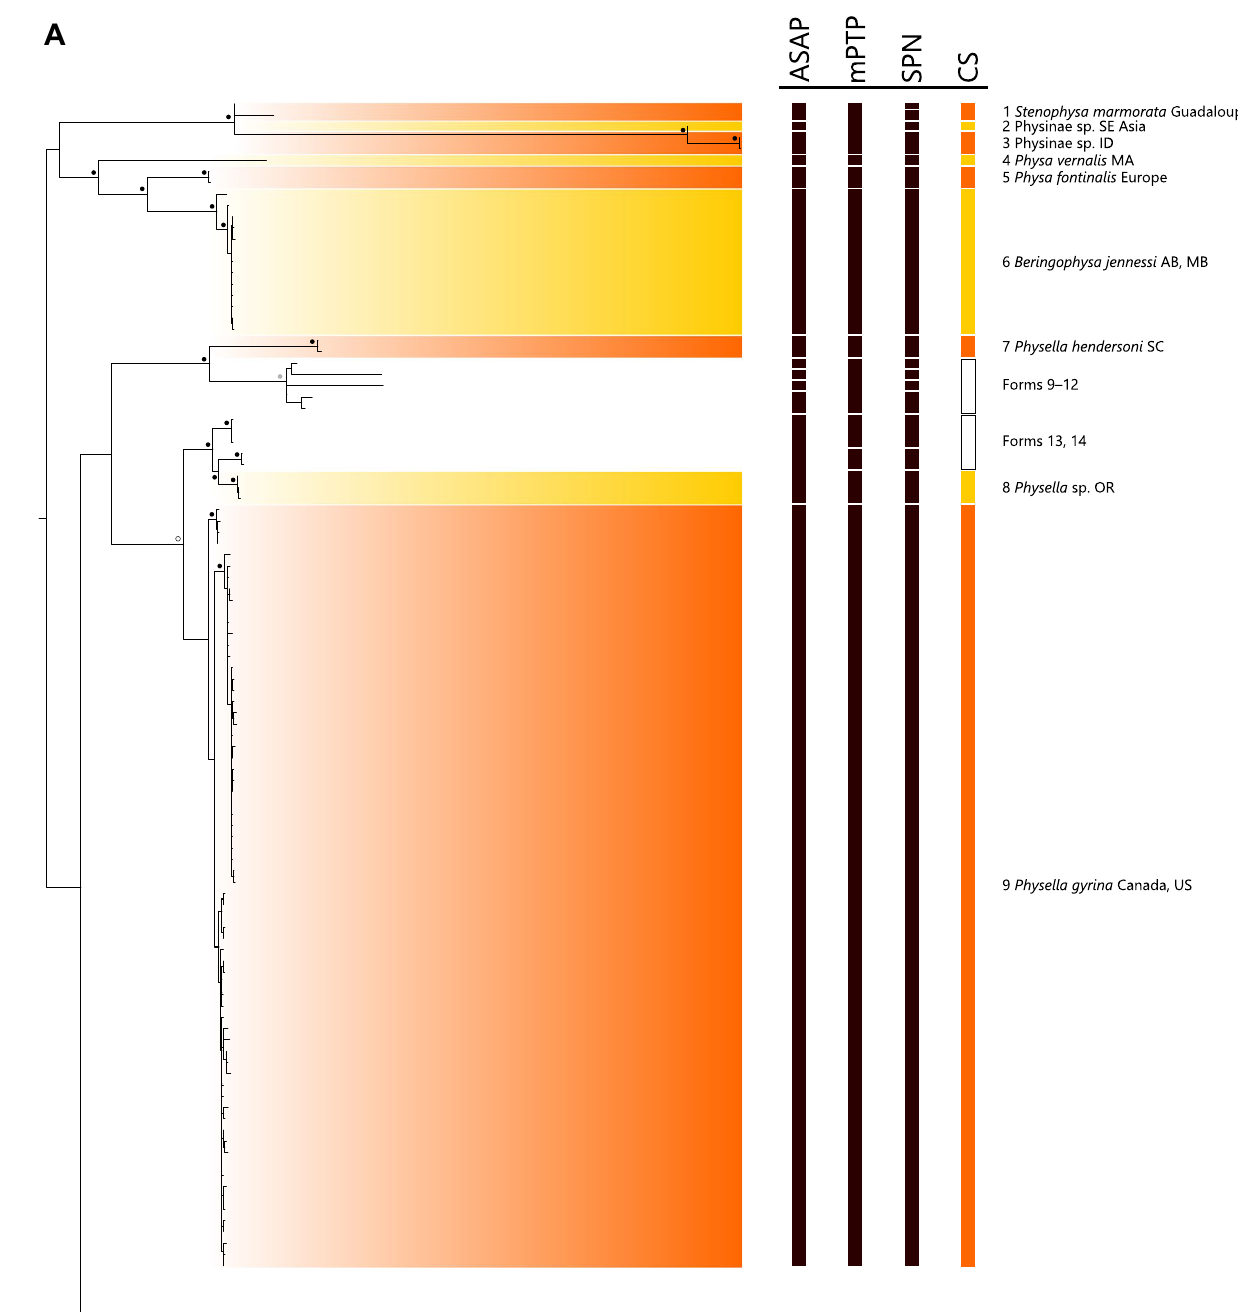
Figure 2. Maximum-likelihood phylogeny of Physinae based on COI haplotypes and the results of species delimitation analyses. CS denotes candidate species; species labels are in Table 1 and sequence labels are in Supplemental Fig. 2. Dots (white, 85–90%; gray, 90–95%; black, > 95%) denote ultrafast bootstrap